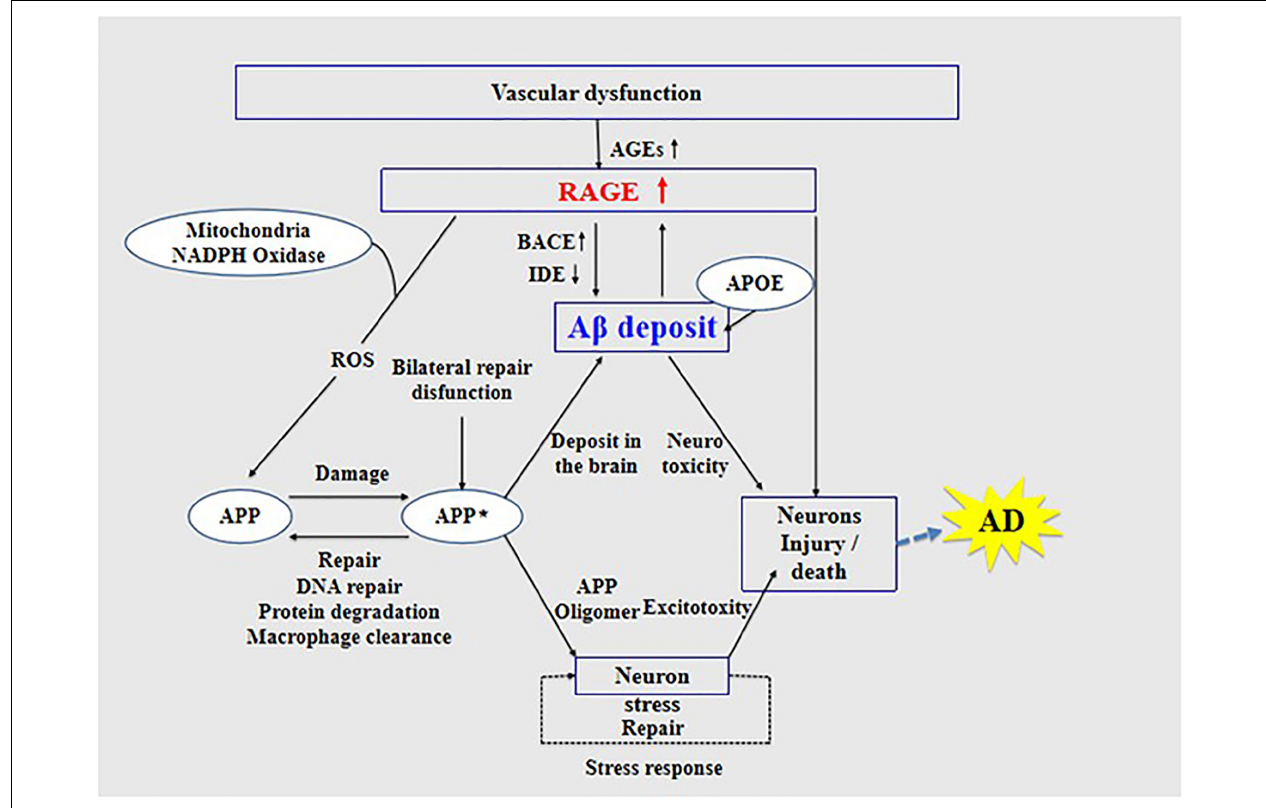
FIGURE 3 | Receptor of advanced glycation end products (RAGE) mediates the possible mechanism of A β in the pathogenesis of Alzheimer’s